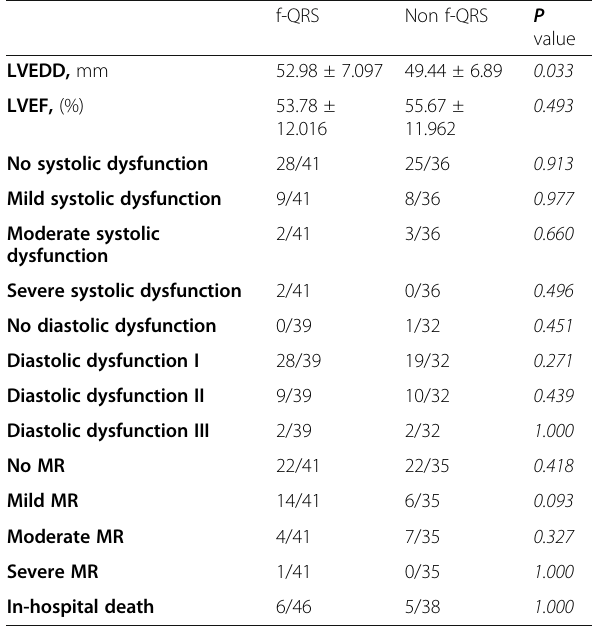
Table 2 Echocardiography data